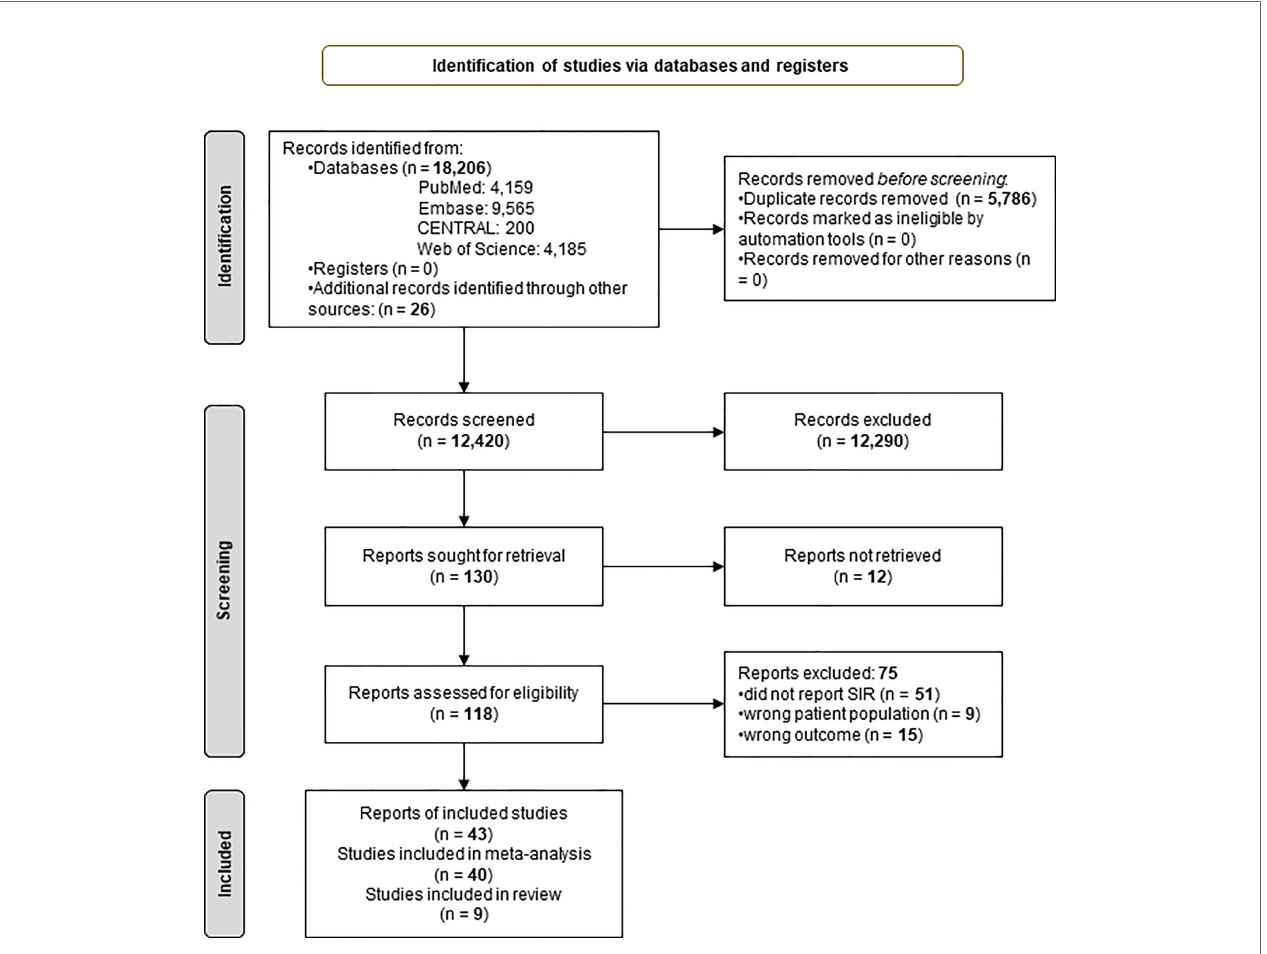
FIGURE 1 | Preferred Reporting in Systematic Reviews and Meta-analyses 2020 (PRISMA) fl owchart showing the selection process